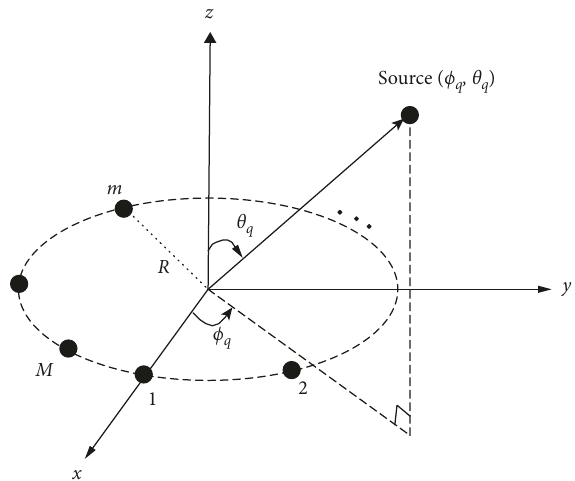
Figure 1: Geometry of an UCA with a narrowband